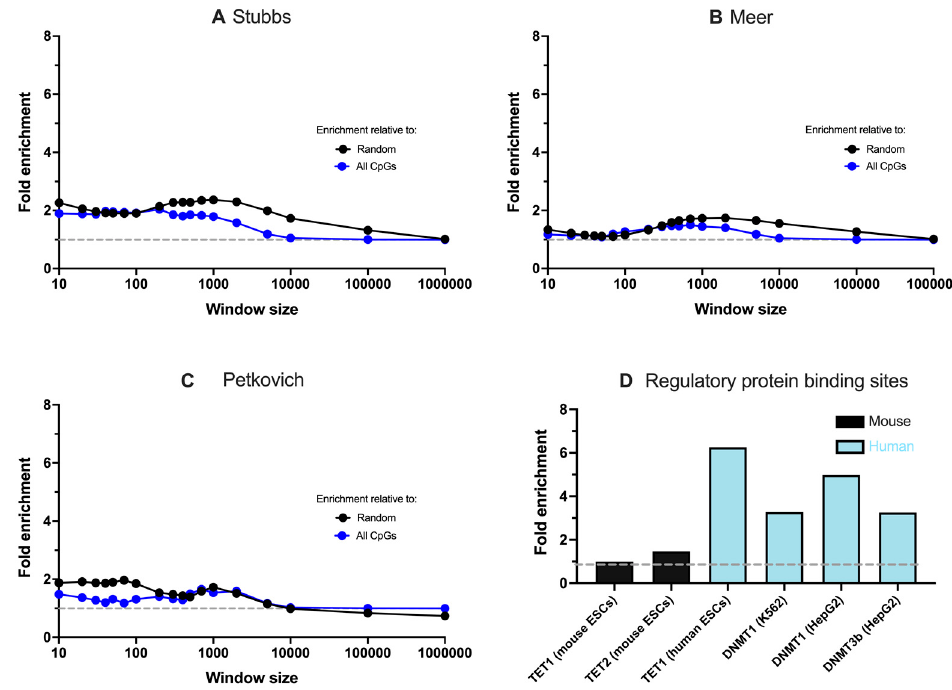
Figure 4. Enrichment of murine G4 sequences at chronological ageing clocks developed by ( A ) Stubbs ( B ) Meer, and ( C ) Petkovich. ( D ) Enrichment of G4-sequences at various TET and DNMT protein binding sites in humans and mice.